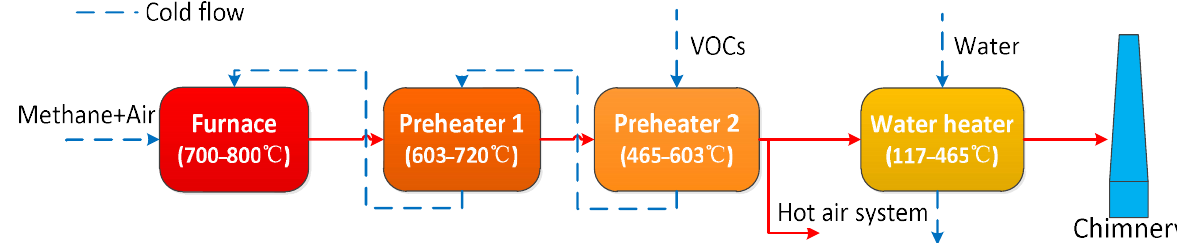
Figure 1. Volatile organic compound (VOC) thermal conversion flow chart.